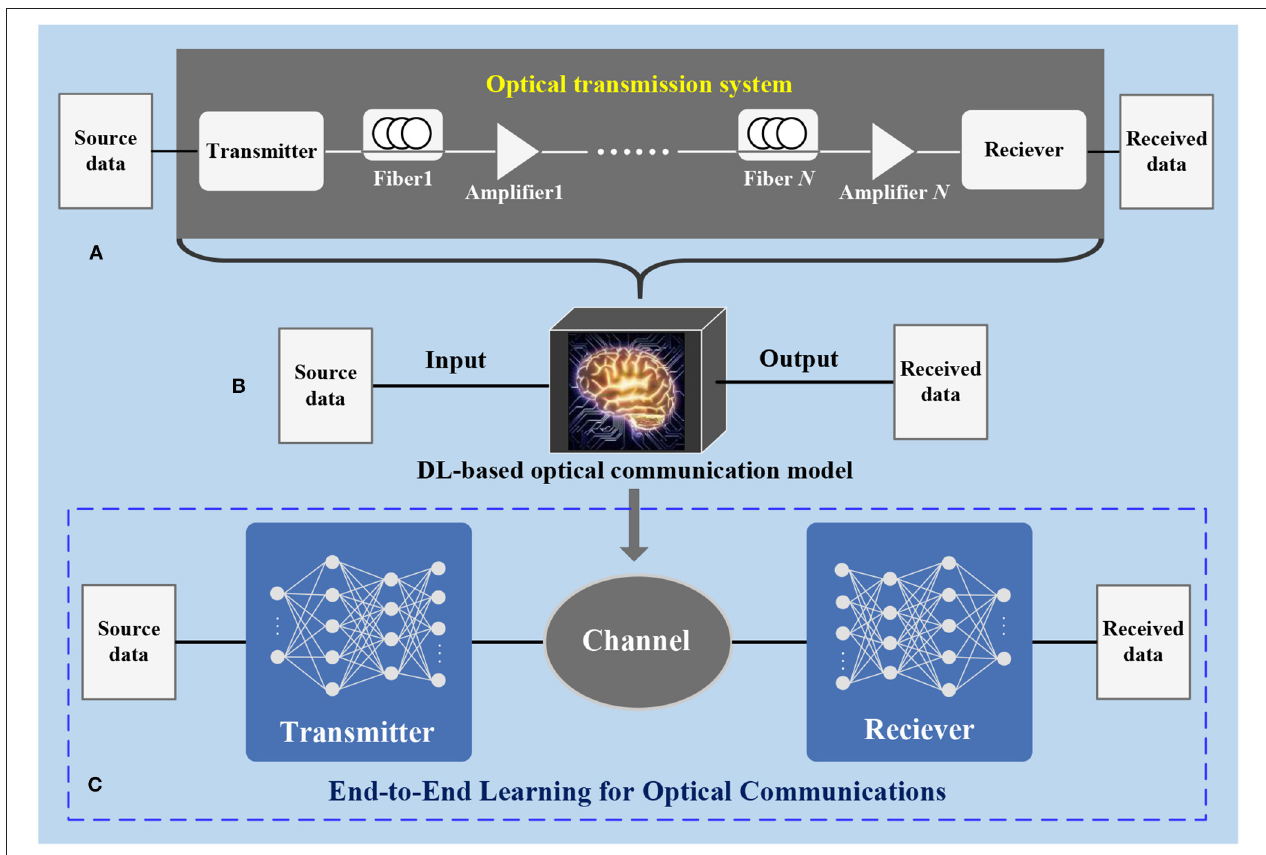
FIGURE 4 | Deep learning for optical communication modeling. (A) The conventional block-based optical communication system, constructed in a divide-and-conquer manner using a series of model blocks. (B) Deep learning-based optical communication model, built by the data-driven multi-layer neural network. (C) Schematic of end-to-end learning for optical communication, based on the DL-based channel